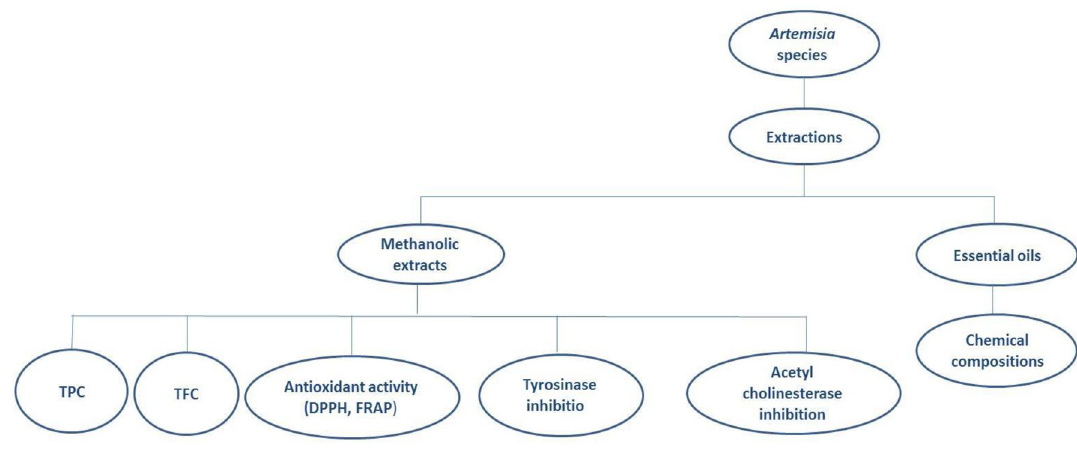
Figure 1. Schematic diagram of the experimental